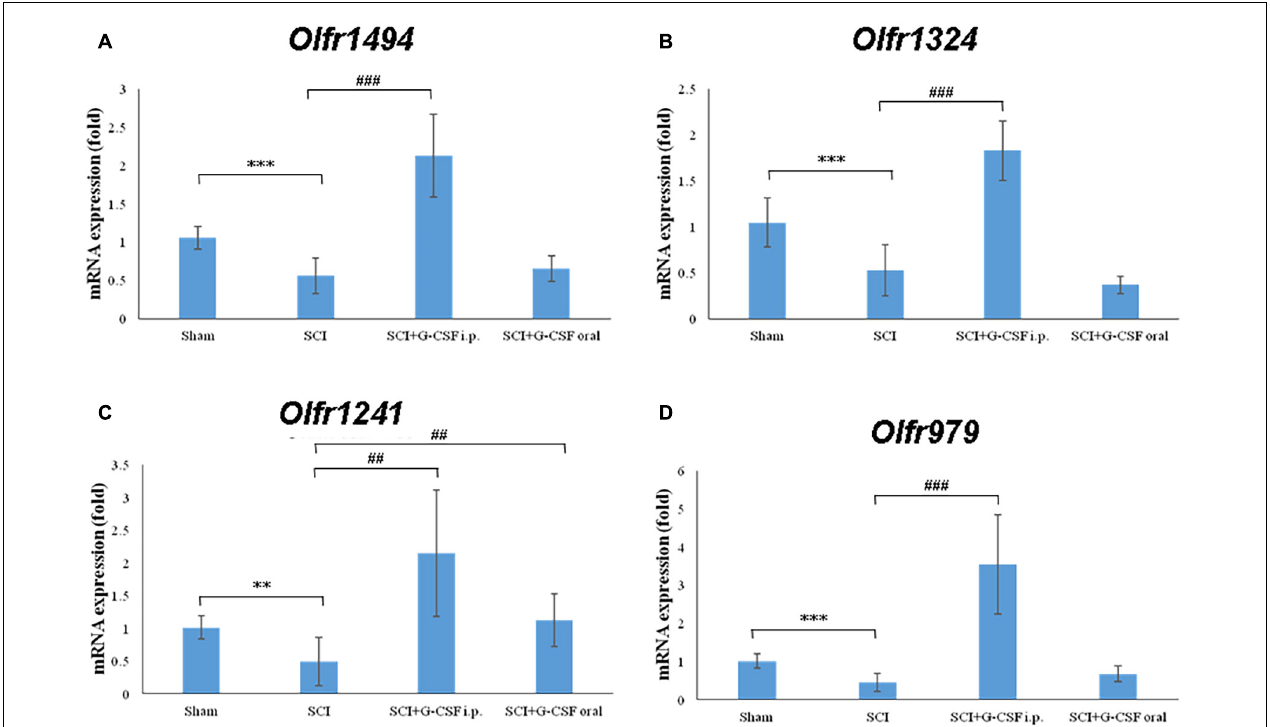
FIGURE 4 | Spinal cord injury (SCI) decreases the expression of olfactory receptors in the olfactory bulb at 8 h post-SCI. The mRNA expression levels of (A) Olfr1494 , (B) Olfr1324 , (C) Olfr1241 , and (D) Olfr979 in the olfactory bulb of the sham control, SCI, SCI + G-CSF i.p., and SCI + G-CSF oral groups. Vertical bars indicate mean ± standard error of mean ( n = 6 in each group). ∗∗ P < 0.01, ∗∗∗ P < 0.001, ## P < 0.01, and ### P <